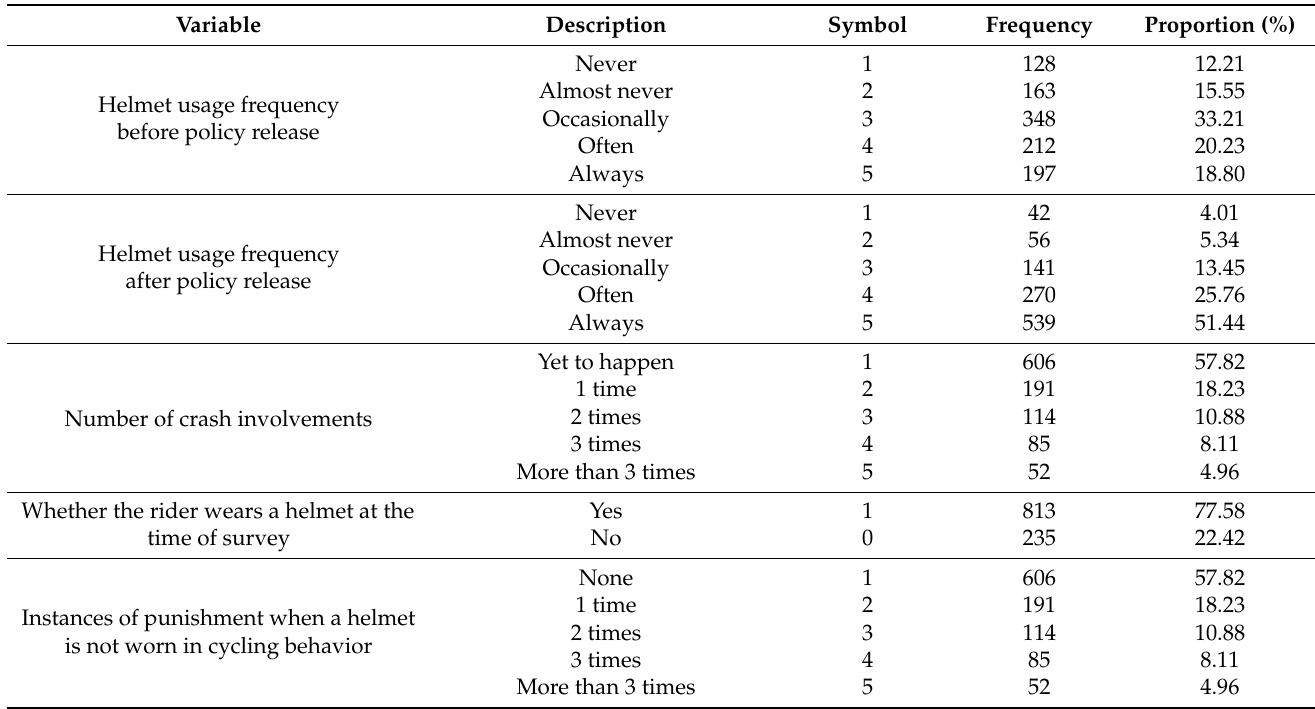
Table 3. Descriptive statistics for cycling behavior information.